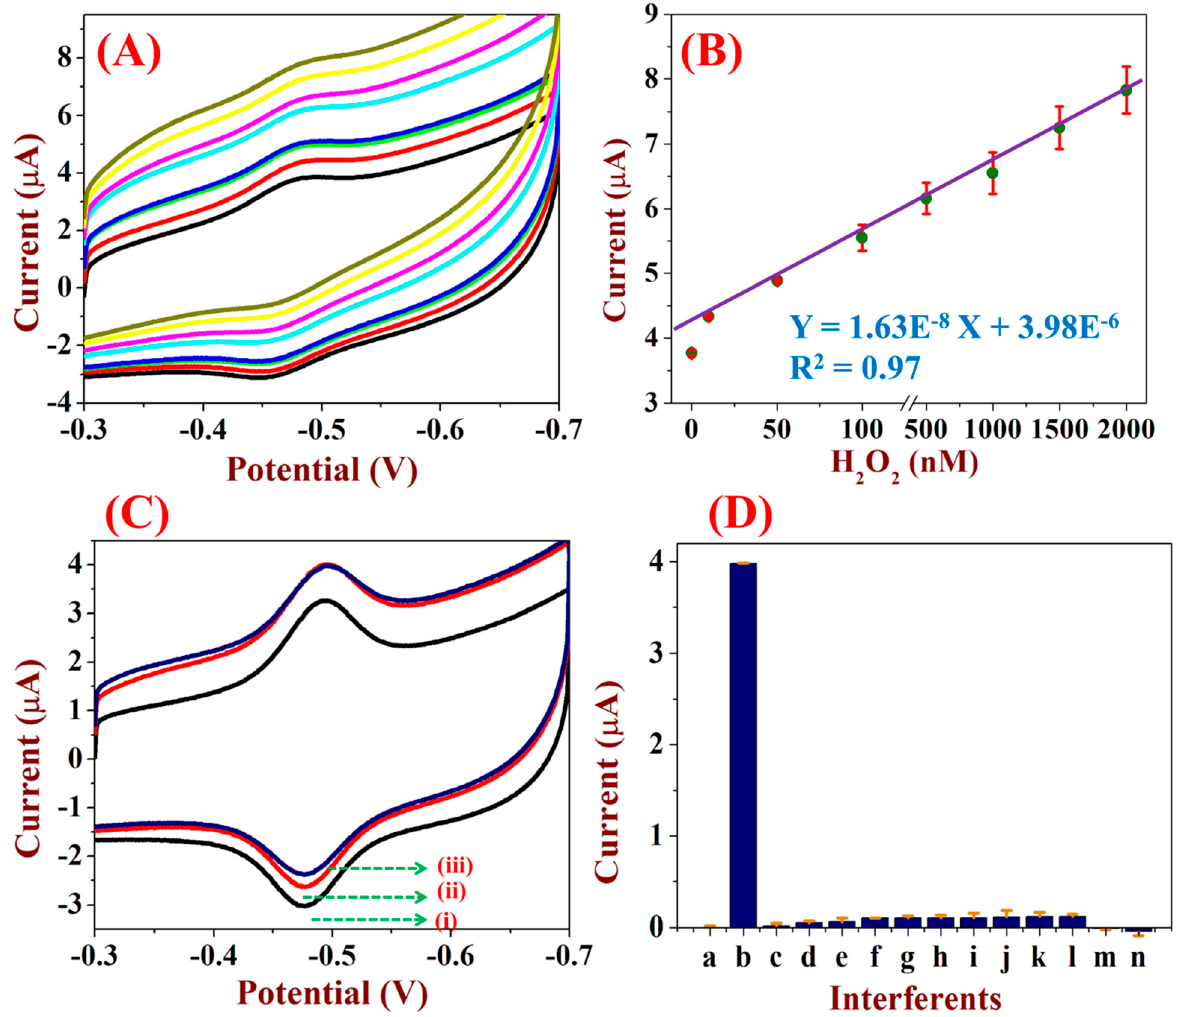
Figure 8. ( A ) CVs of FAD/Ti 3 C 2 T x /GCE were recorded in 0.1 M PBS with different concentrations of H 2 O 2 from 5 nM to 2 µ M at a scan rate of 50 mV/s. ( B ) The calibration plot was established between the concentrations of H 2 O 2 and the reduction peak currents. ( C ) CVs were recorded using FAD/Ti 3 C 2 T x modified electrode in 0.1 M PBS before (curve i) and after addition of 100 nM H 2 O 2 (curve ii) and (curve iii) represents CV curve after the addition of 1 µ M concentration of each interfering molecule with 100 nM H 2 O 2 . ( D ) The bar diagram represents the changes in the current responses caused by FAD/Ti 3 C 2 T x /GCE with (a) 0 nM H 2 O 2 and (b) 100 nM H 2 O 2 . The catalytic current was recorded after the addition of 1 µ Μ of each interfering molecule, (c) L-alanine, (d) L-isoleucine, (e) L-cysteine, (f) NaCl, (g) KCl, (h) glucose, (i) lactose, (j) AA, (k) UA, (l) OA (m) PA, and (n) DA (these experiments were repeated three times and the SD values are given, n = 3).